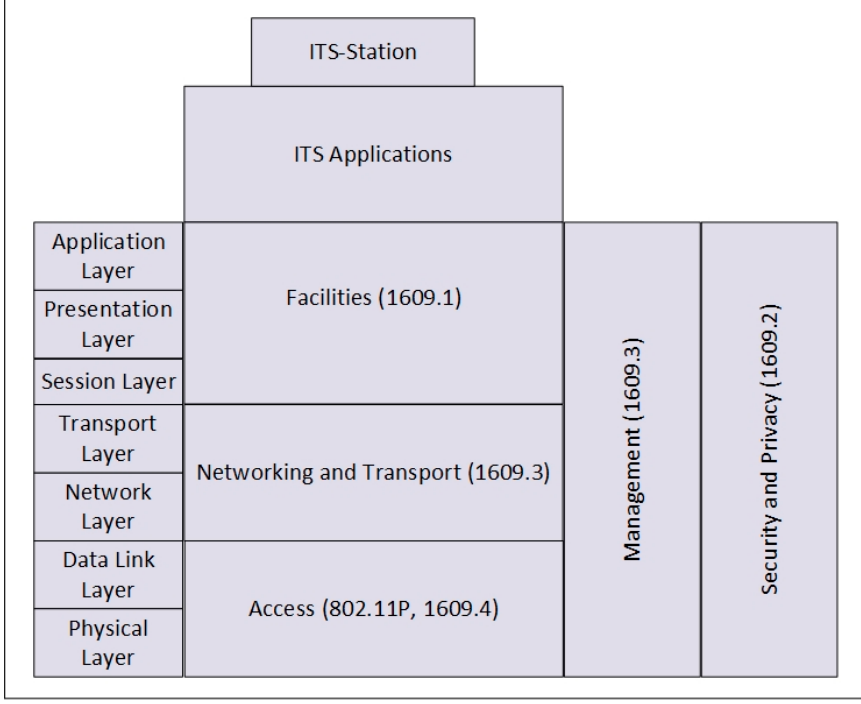
Figure 4. ITS-S architecture with 802.11P/WAVE and IEEE 1609.x.